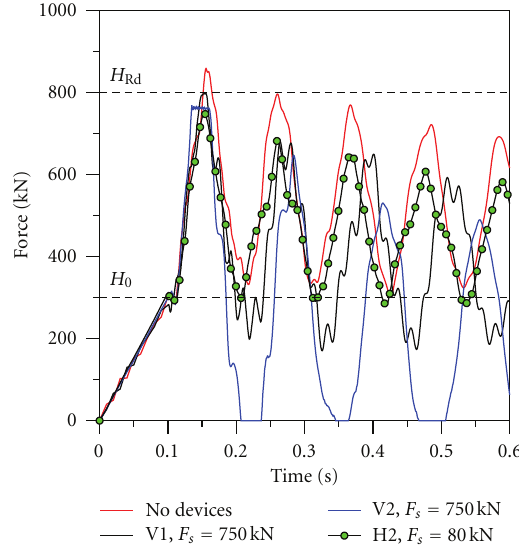
Figure 16: Comparison of axial force in the cables, as a function of time (ABAQUS). M02 FE-model,